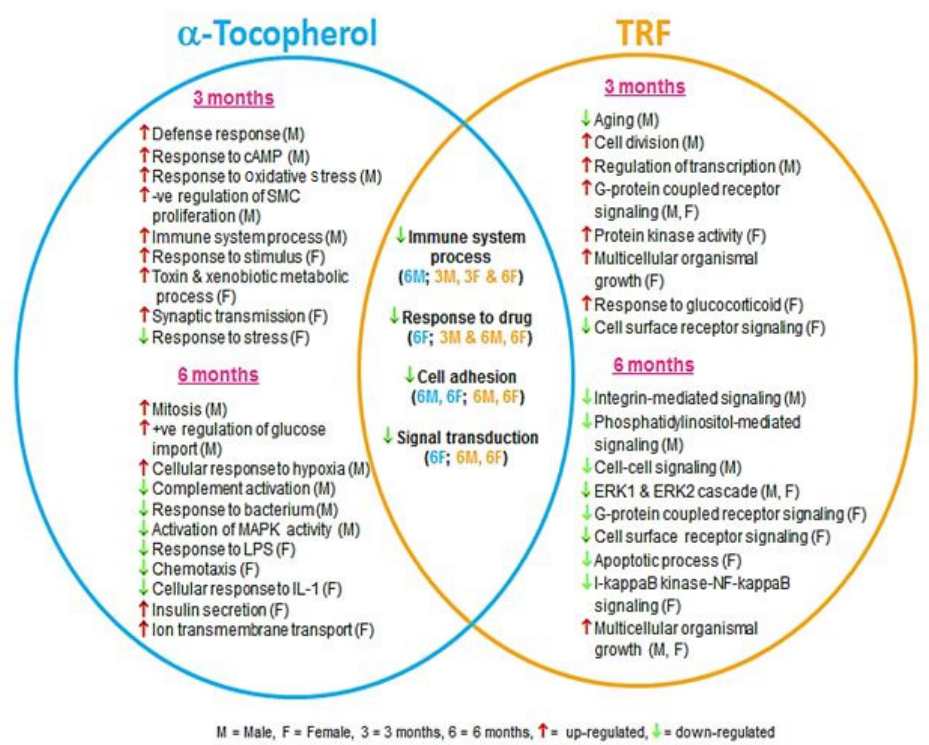
Figure 2 - Biological processes significantly modulated in both male and female subjects after 3 and 6 months of α -TF and TRF